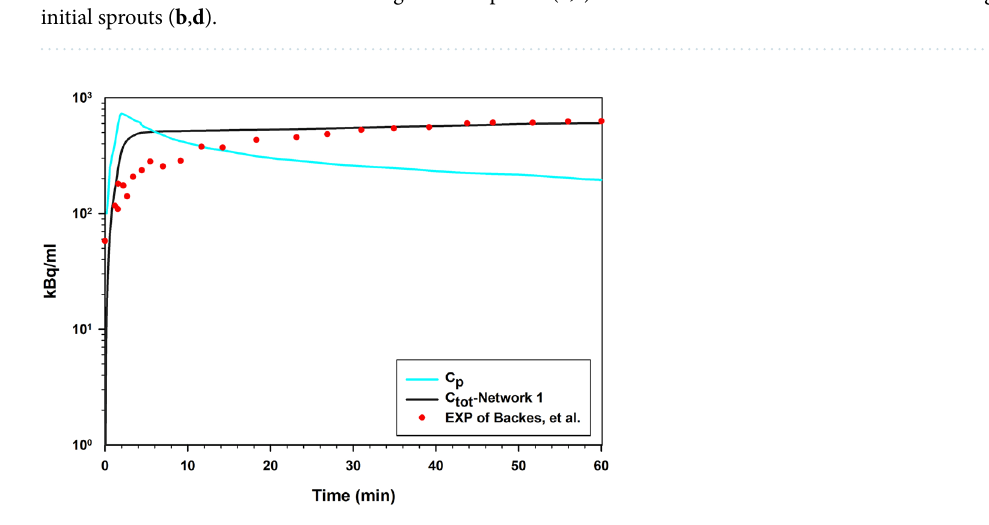
Figure 13. Comparison of results for SDM model with experimental results of Backes et al. 81 for FDG in tumor region over